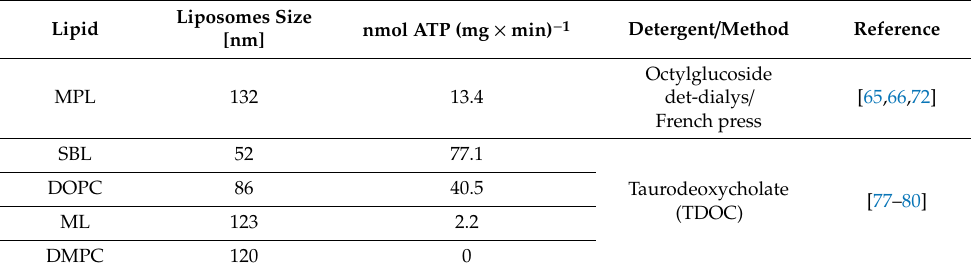
Table 15. Co-reconstitution and light-driven ATP